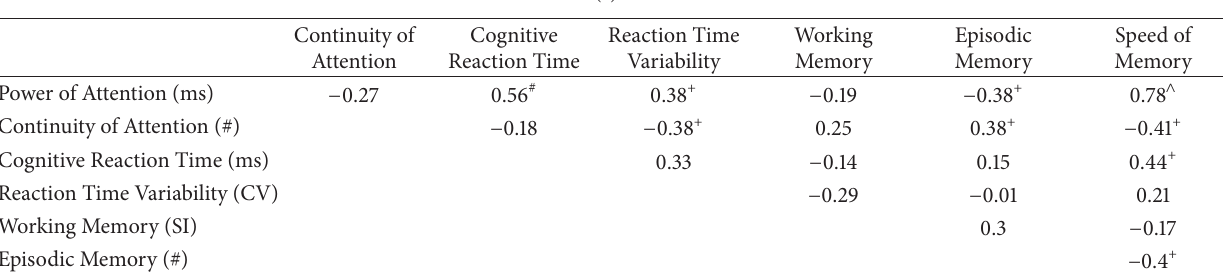
Table 1: (a) Pearson coefficients for the intercorrelations between cognitive domain scores in persons with CIS and eRRMS ( 𝑁 = 33 ). (b) Pearson coefficients for the intercorrelations between cognitive domain scores in age-matched controls ( 𝑁 = 1409 ).